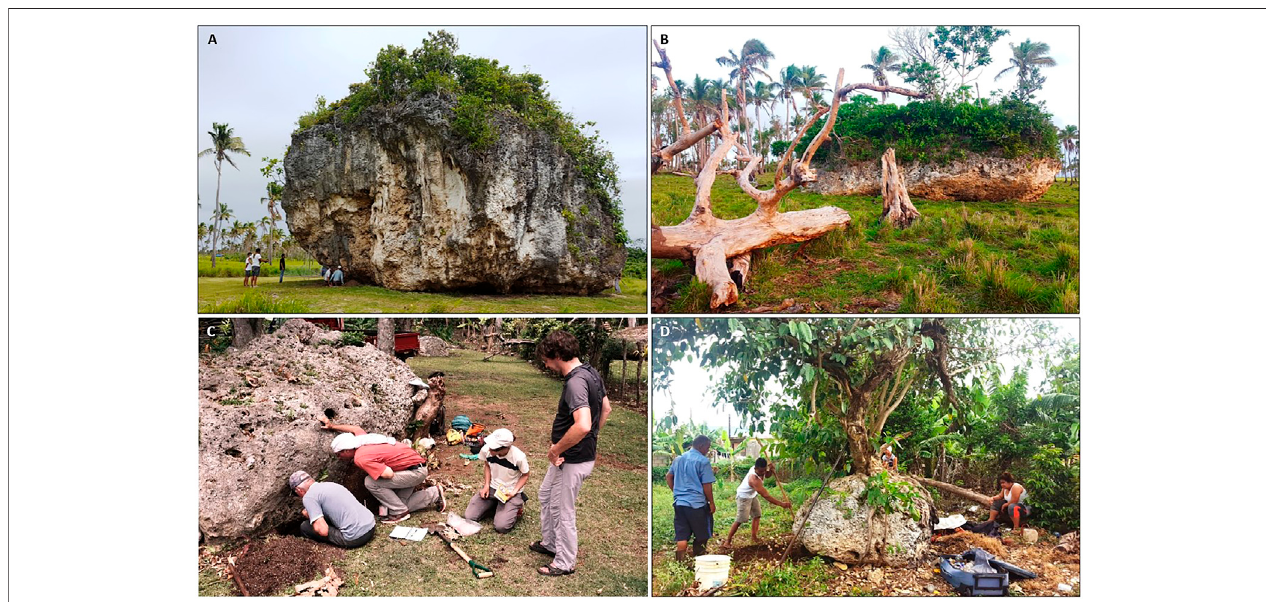
FIGURE 3 | Tsunami boulders in Tongatapu. (A) The sacred Maui Rock in Faheha, 10 m a.s.l. ( ∼ 780 m 3 ); (B) Second largest megablock at Fahefa, 13.5 m a.s.l. ( ∼ 230 m 3 ); (C) Boulder at Haveluliku, 30 m asl; (D) The sacred Masila boulder at Alaki (Mu ’ a town).